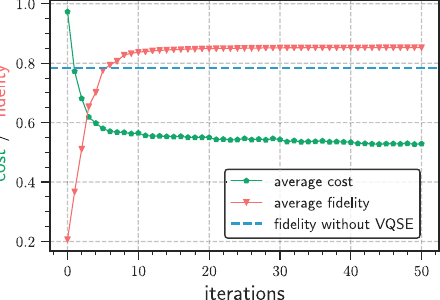
Fig. 6 Cost function value and fi delity versus number of iterations. We implement VQSE for error mitigation of the three qubit W -state preparation circuit. The input state ρ corresponds to the mixed state obtained by running the W -state preparation circuit on a noisy simulator. The dashed line corresponds to the fi delity F ð ρ ; ψ j iÞ between ρ and the the exact W state ψ j i . For each iteration step, we compute the fi delity F ð σ ; ψ j iÞ , where the mixed state σ is obtained by running the VQSE eigenvector preparation circuit on the noisy simulator. Curves depict the average of 10 instances of the algorithm. As the number of iterations increases the cost function value decreases, which implies that we are able to train V ( θ ) in the presence of noise. After a few iterations of the VQSE optimization loop, we fi nd F ð σ ; ψ j iÞ >F ð ρ ; ψ j iÞ